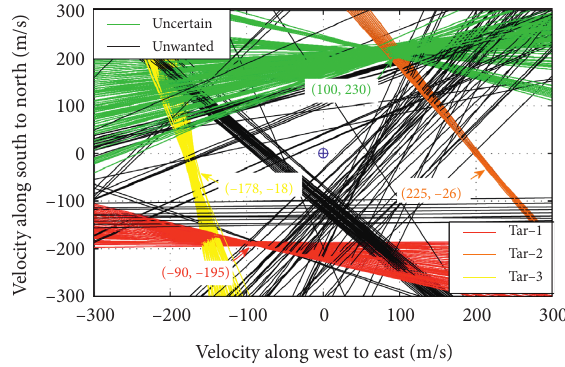
Figure 13: Constant velocity equation map with measured